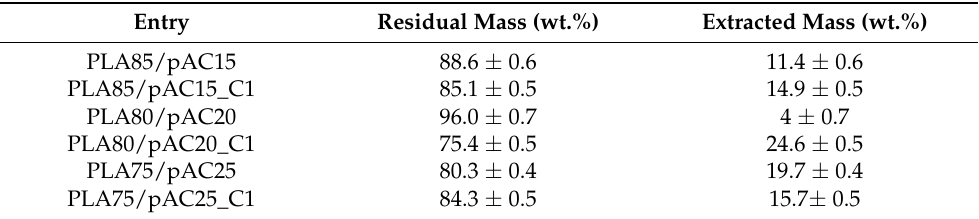
Table 4. Results related to dissolution tests performed onto extruded strands of the blends with 75, 80, and 85% of PLA and pure pAC, pAC/C1 in 4/1